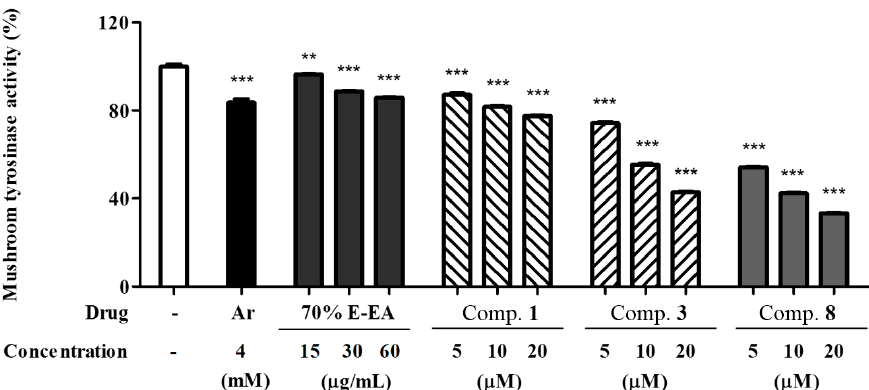
Figure 2. Inhibitory effects of M. alba leaves on mushroom tyrosinase activity; a mushroom tyrosinase activity was assayed by measuring 3,4-dihydroxyphenylalanine (DOPA) oxidase activity. The test samples were diluted in sodium phosphate buffer (67 mM, pH 6.8) and added to the samples in 96-well plates. Then, L -dopa (2 mM) and mushroom tyrosinase (200 U) were added to each well for 10 min. The absorbance was measured at 490 nm by using an ELISA microplate reader. Results are expressed as percentages of ** p < 0.01 and *** p < 0.001 compared with the control group. 70% E-EA indicates ethyl acetate fraction from 70% ethanol extract of M. alba leaves.